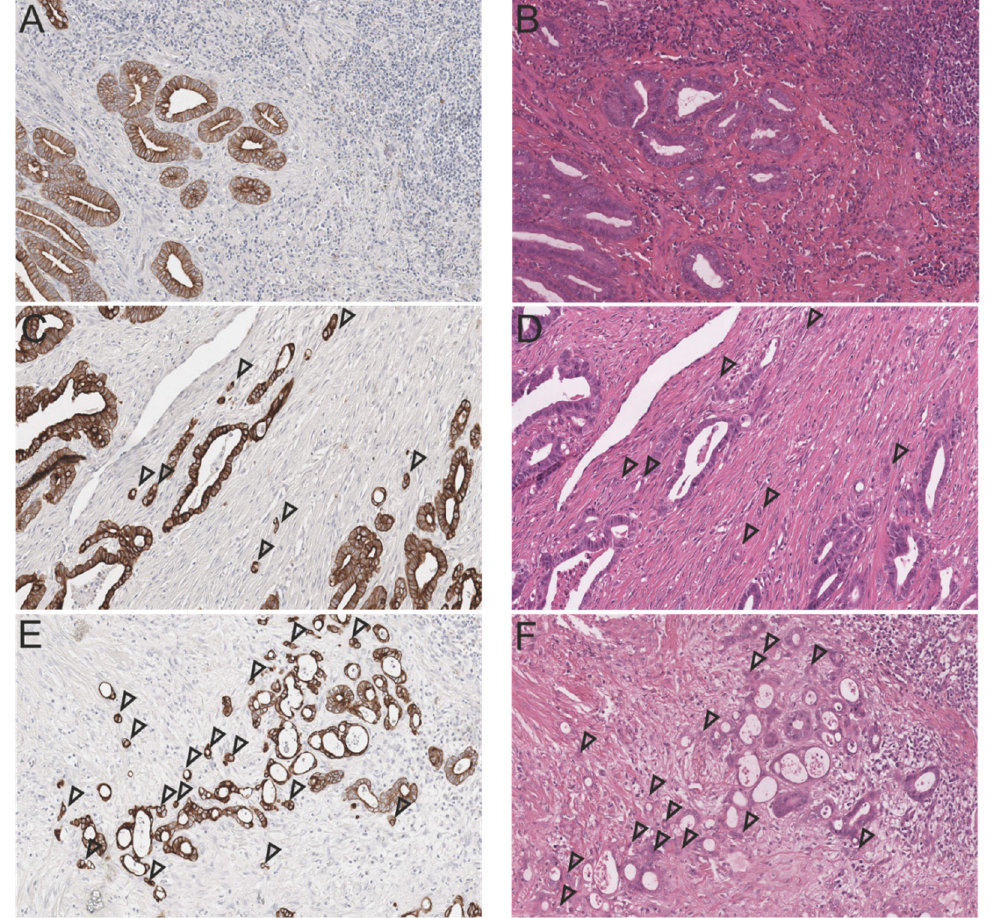
Figure 1. Tumor budding (TB) in the invasive front of feline intestinal carcinomas according to the 3-tier-system for budding assessment of human CRC (left: Pan-cytokeratin, right: H&E, consecutive sections, 20×). Tumor buds are indicated by arrow heads; ( A ) Low TB activity (Bd1, Pan-cytokeratin); ( B ) Low TB activity (Bd1, H&E); ( C ) Moderate TB activity (Bd2, Pan-cytokeratin); ( D ) Moderate TB activity (Bd2, H&E); ( E ) High TB activity (Bd3, Pan-cytokeratin); and ( F ) High TB activity (Bd3, H&E). For corresponding human H&E sections see Figure S1.